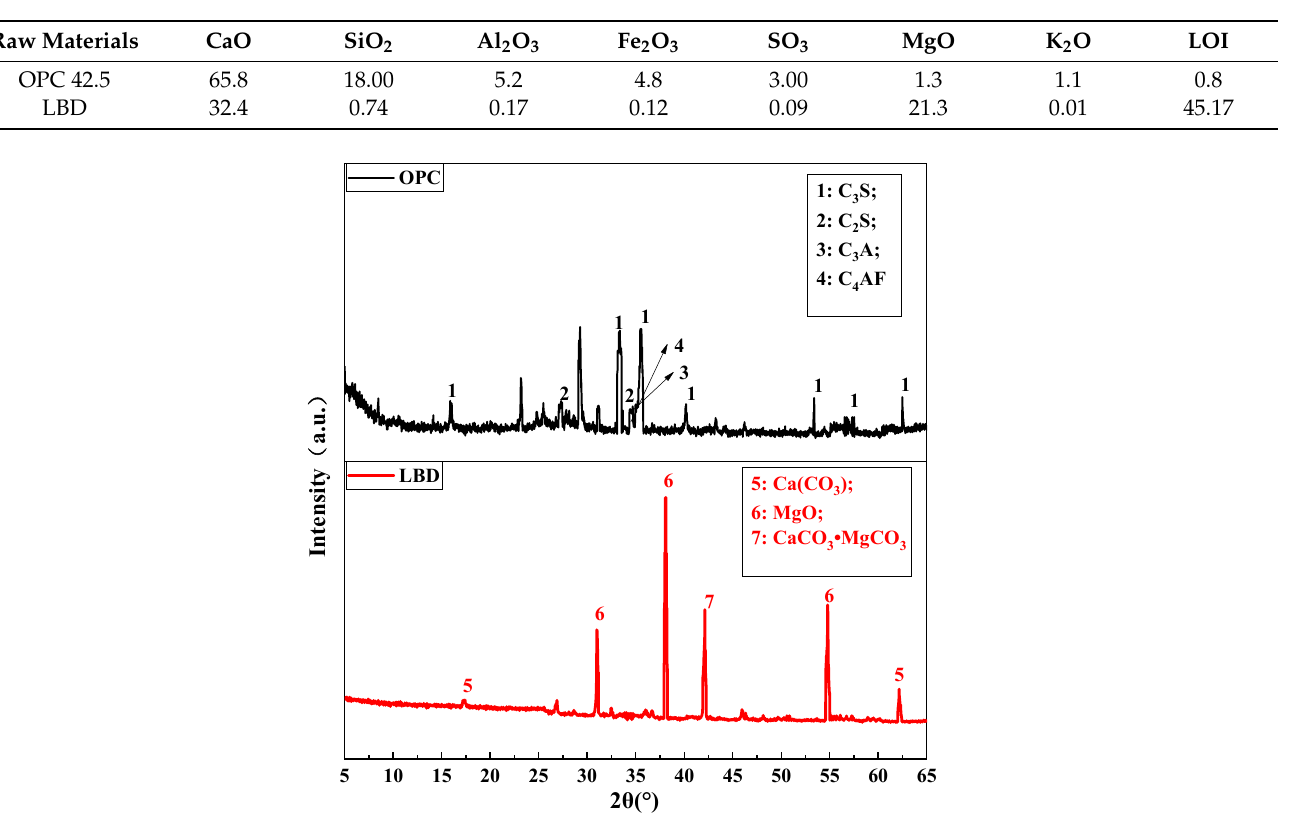
Figure 1. XRD patterns for OPC and LBD powders.